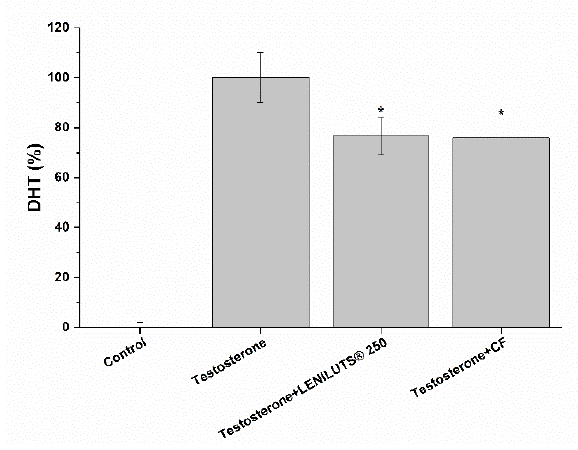
Figure 4. Percentage of DHT produced by 5 α R from testosterone reduction, calculated compared to control, in the presence or absence of LENILUTS ® and CF. * p < 0.05 vs. testosterone.